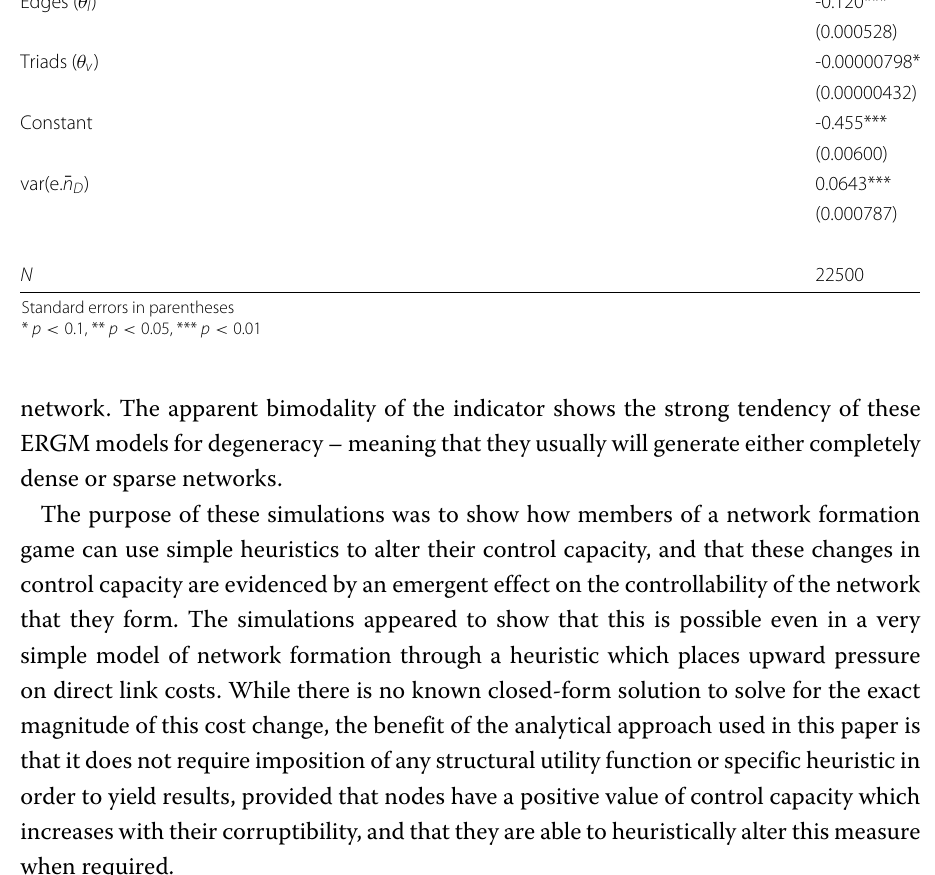
Table 1 Tobit regression analysis of simulated network controllability Edges ( θ l ) -0.120*** Triads ( θ v )